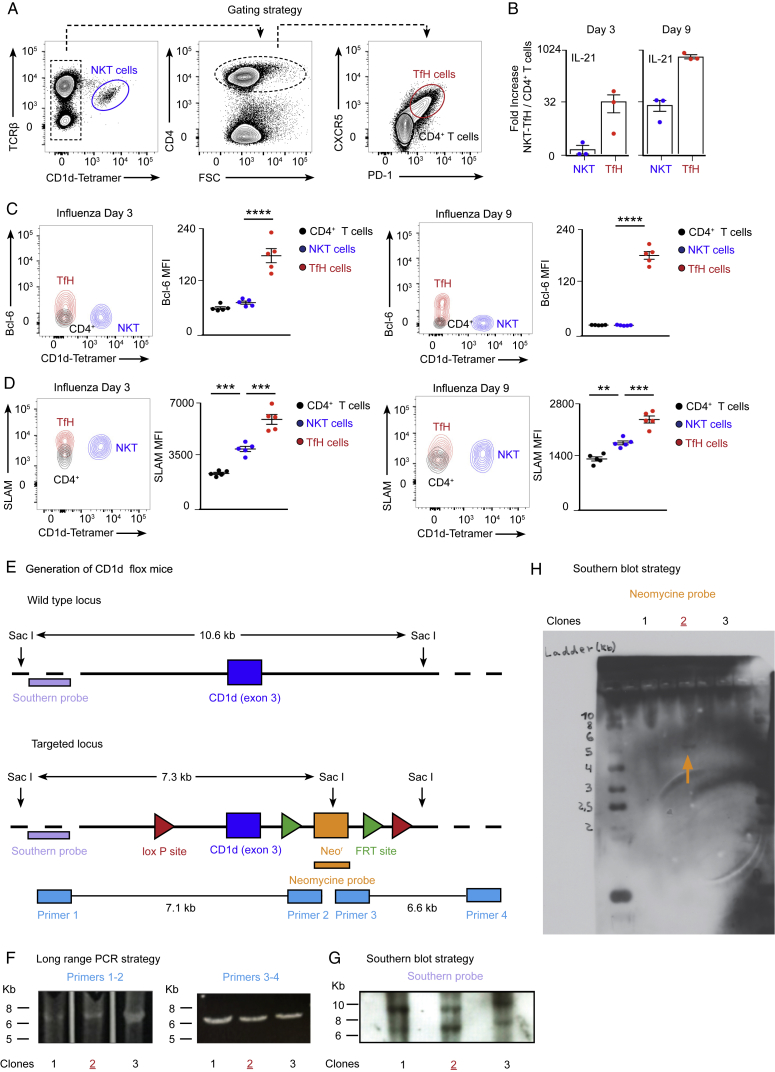
Expression Analysis of TfH Markers by NKT Cells and Strategy for the Generation of CD1d-Floxed ESCs, Related to Figure 2(A) Flow cytometry gating strategy for the analysis of NKT cells (TCRβ+ CD1d tetramer+), CD4+ T cells (TCRβ+ CD1d tetramer- CD4+) and TfH cells (TCRβ+ CD1d tetramer- CD4+ CXCR5+ PD-1+) in mediastinal lymph nodes at day 9 of influenza infection.(B) RT-qPCR analysis of IL-21 expression at day 3 and 9 of influenza infection by sorted NKT and TfH cells compared to CD4+ cells.(C and D) Representative contour plots show the expression of (C) Bcl-6 and (D) SLAM by NKT, TfH and CD4+ T cells at day 3 and 9 of infection. Quantification on the right charts shows the mean fluorescence intensity for (C) Bcl-6 and (D) SLAM.(E) Scheme showing the wild type and targeted CD1d locus containing two loxP sites flanking the exon 3 of CD1d as well as two FRT sites for the removal of the Neomycin resistance cassette.(F) Specific fragments amplified by long-range PCR for the 5′ end (7.1kb) and 3′ end (6.6kb) of the clones that correctly performed homologous recombination.(G) DNA from three positive clones was digested with SacI restriction enzyme and Southern blot performed using a labeled Southern probe. The upper band corresponds to the wild type locus (10.6kb) and the lower band to the targeted locus (7.3kb).(H) Southern blot of the three positive clones performed with a labeled Southern probe against the Neomycin cassette. Orange arrow indicates the single 5.2kb band recognized by this probe, indicating single insertion of the construct. The clone 2, in red, was chosen for injections.In all quantification charts, each dot represents one mouse. Data are representative from three experiments. Statistical analysis two-tailed Student’s t test; ∗∗p < 0.01, ∗∗∗p < 0.001 and ∗∗∗∗p < 0.0001.